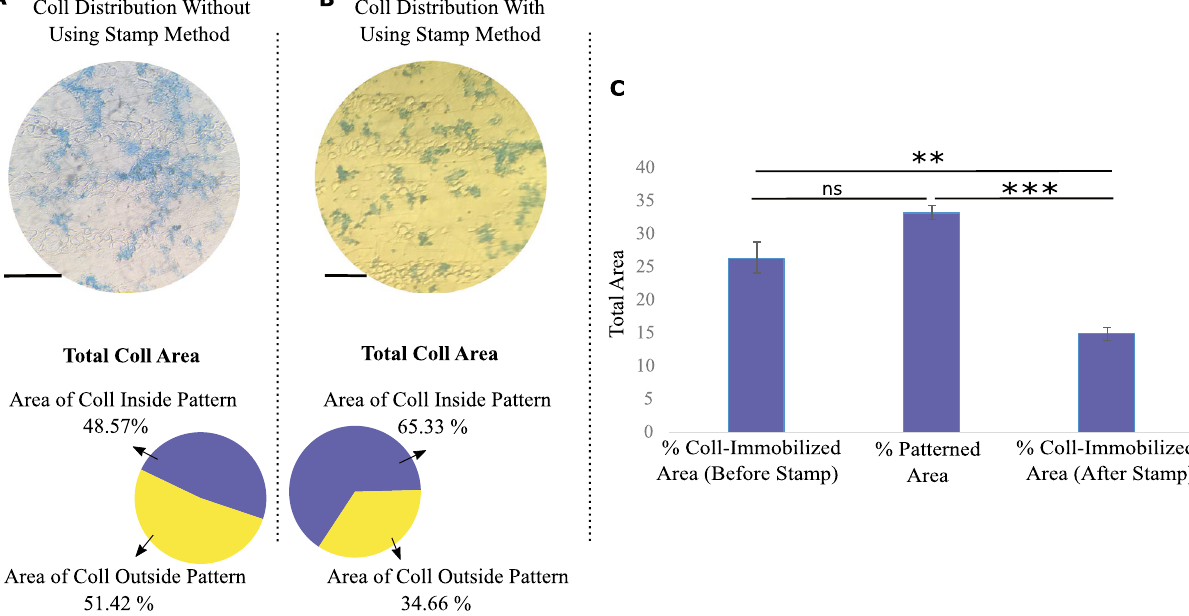
Figure 3. Illustration of the collagen distribution and the ratio of collagen inside to the outside pattern after 14 days by Coomassie brilliant blue staining on the samples ( A ) without and ( B ) using the stamp method (Scale bar = 80 μm). ( C ) The total area of the collagen immobilized before and after the stamp method compared to the total patterned area after 14 days. The graph represents the mean ± SD. ** p value of < 0.01, *** p value of < 0.001, and (ns) indicates a statistically non-significant result between two groups (N =